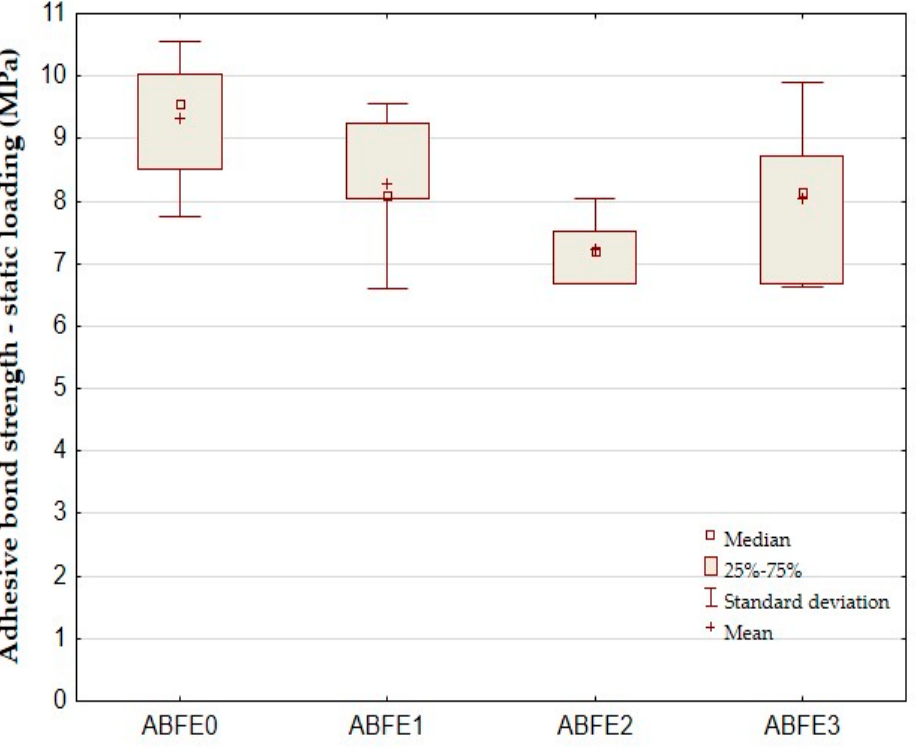
Table 3. Statistical testing of adhesive bonds—adhesive bond shear strength, elongation at break and modulus of elasticity.